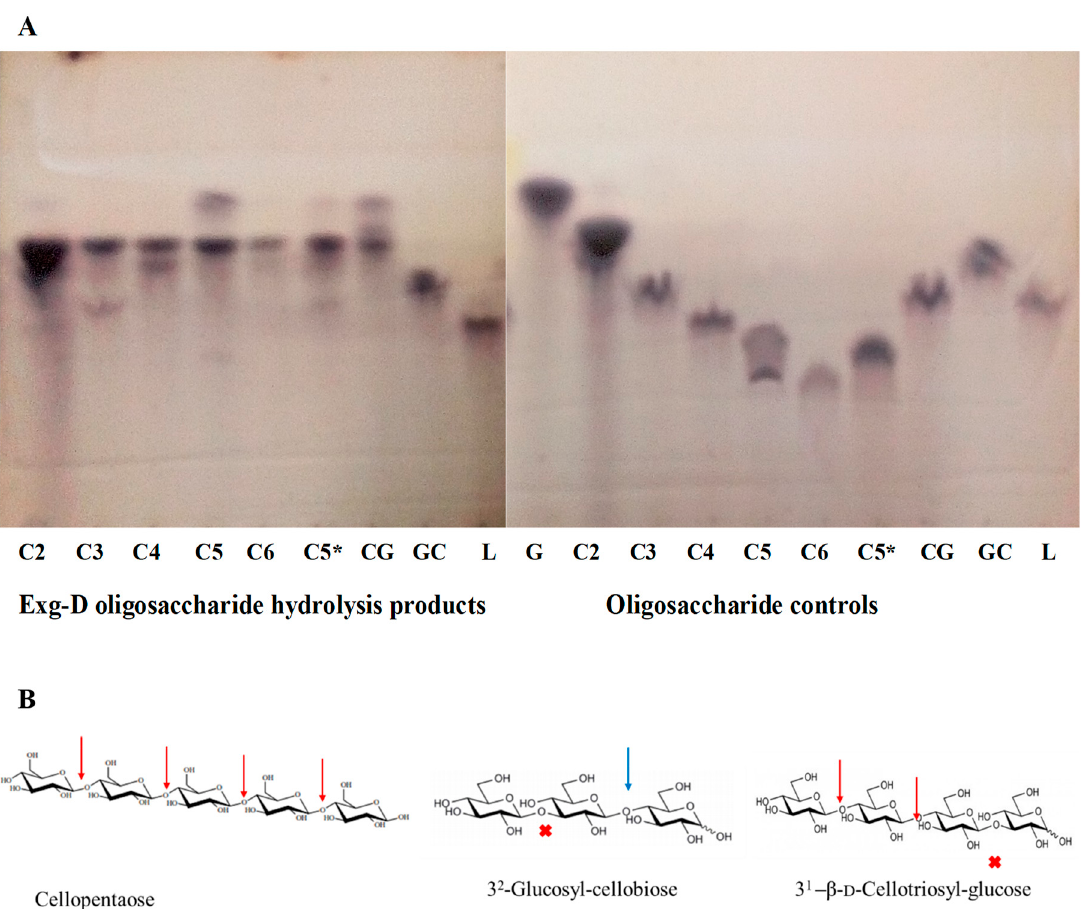
Figure 3. Thin-layer chromatography (TLC) showing the oligosaccharide hydrolysis products of the Exg-D enzyme and the controls ( A ). C2 to C6 represent the cello-oligosaccharides with degrees of polymerisation of 2 to 6, respectively. C3 to C6 were borohydride-reduced, while C2 and C5* were not reduced with borohydride. The CG and GC represent the 3 1 - β - d -cellotriosyl-glucose and 3 2 -glucosyl-cellobiose, while L represents the laminaripetaose. Cellopentaose, 3 2 -glucosyl-cellobiose and 3 1 - β - d -cellotriosyl-glucose were used to indicate Exg-D hydrolysis cleavage sites ( β -1,4-glycosidic bonds (red arrows)) and the sites that were not hydrolysed by the enzyme ( β -1,3-glycosidic bonds (red cross)) ( B ). The blue arrow shows the potential hydrolysis cleavage site ( β -1,4-glycosidic bonds) but the requirement for Exg-D hydrolysis action is two β -1,4-glycosidic bonds, not one.